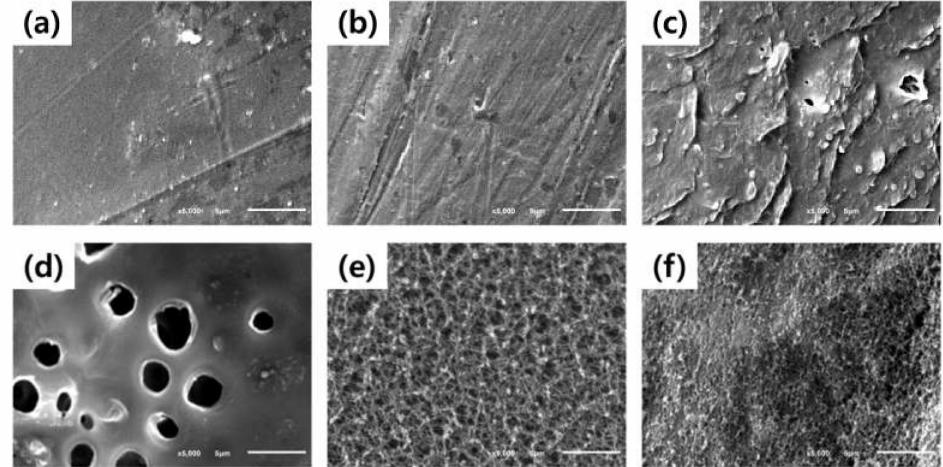
Figure 2. SEM images of PEKK surface after H 2 SO 4 treatment: ( a ) Untreated PEKK, ( b ) 12.5 mol/L H 2 SO 4 , ( c ) 13.4 mol/L H 2 SO 4 , ( d ) 14.3 mol/L H 2 SO 4 , ( e ) 15.1 mol/L H 2 SO4 and ( f ) 18.0 mol/L H 2 SO 4 for 3 min at room